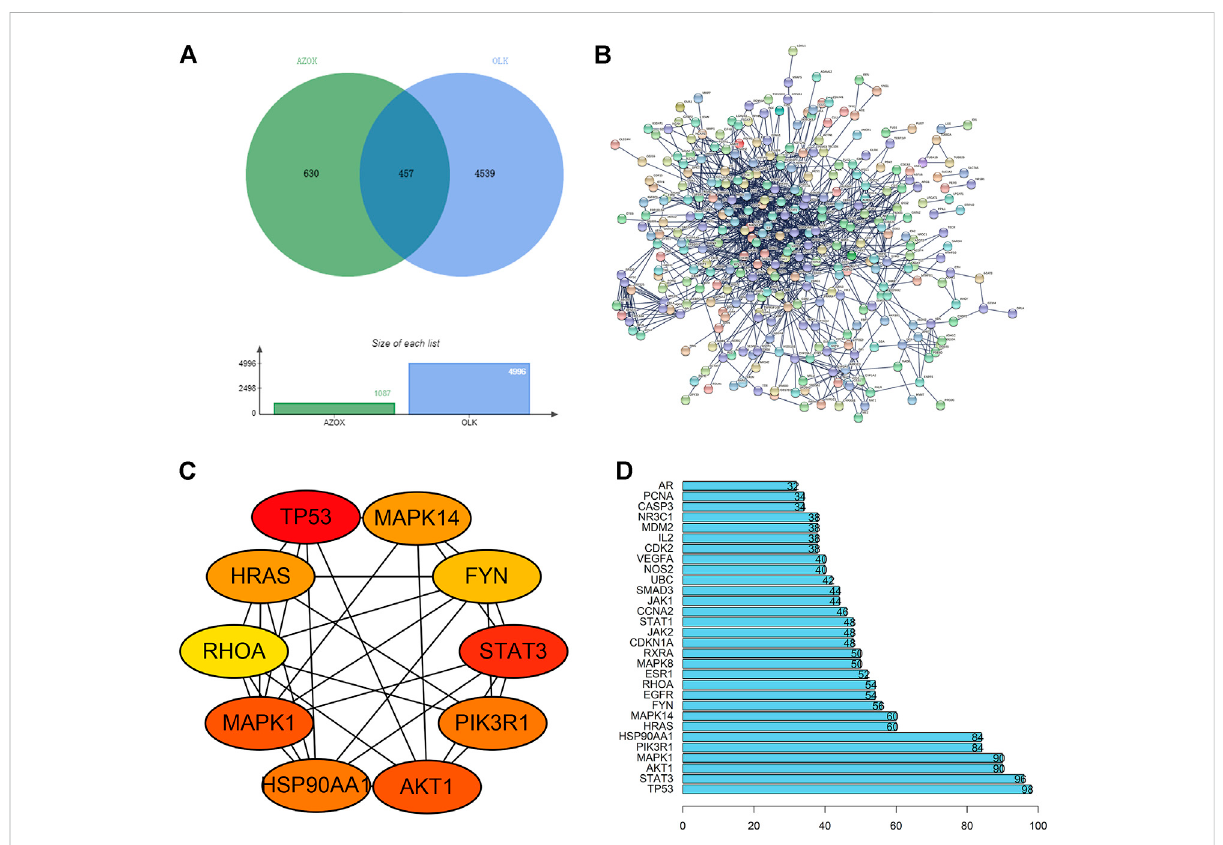
FIGURE 1 The process of screening core targets. (A) Venn diagram of the AZOX and OLK targets. (B) PPI network of overlapping genes (the potential targets) related to both OLK and AZOX. (C) The interaction network of top ten hub genes. (D) The top 30 genes selected from the PPI network of intersection genes according to the node